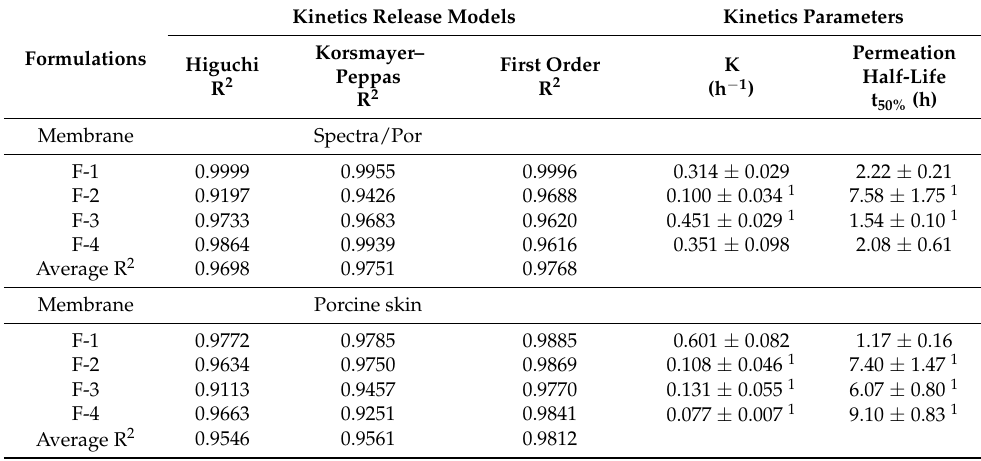
Table 3. Permeation rates and R 2 regression coefficients for the prepared MC-based hydrogel formu- lations containing